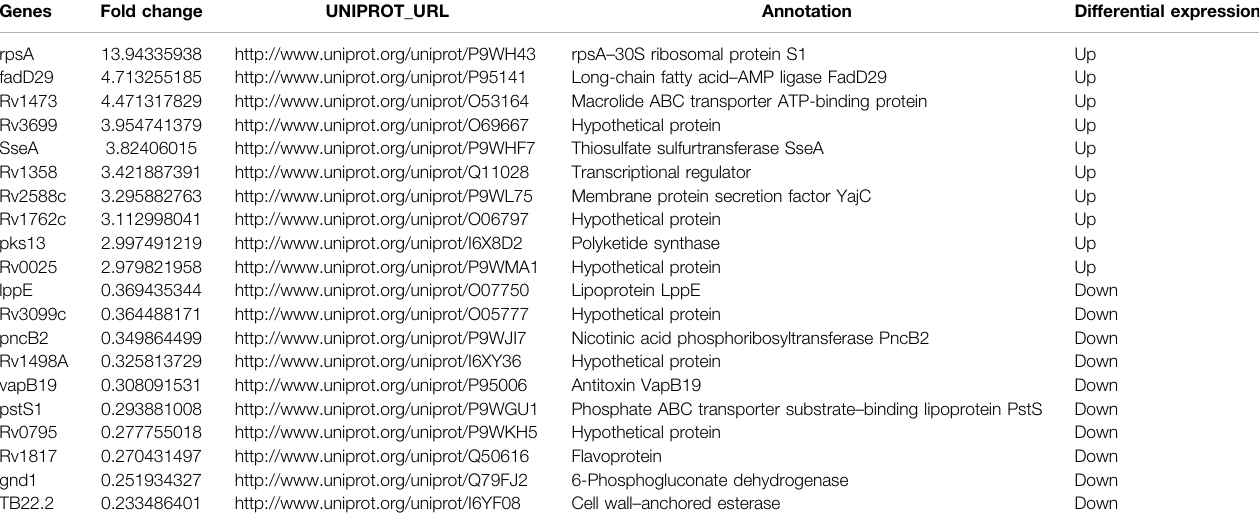
TABLE 3 | The top10 differentially expressed proteins between intracellular BCG and M.tb .